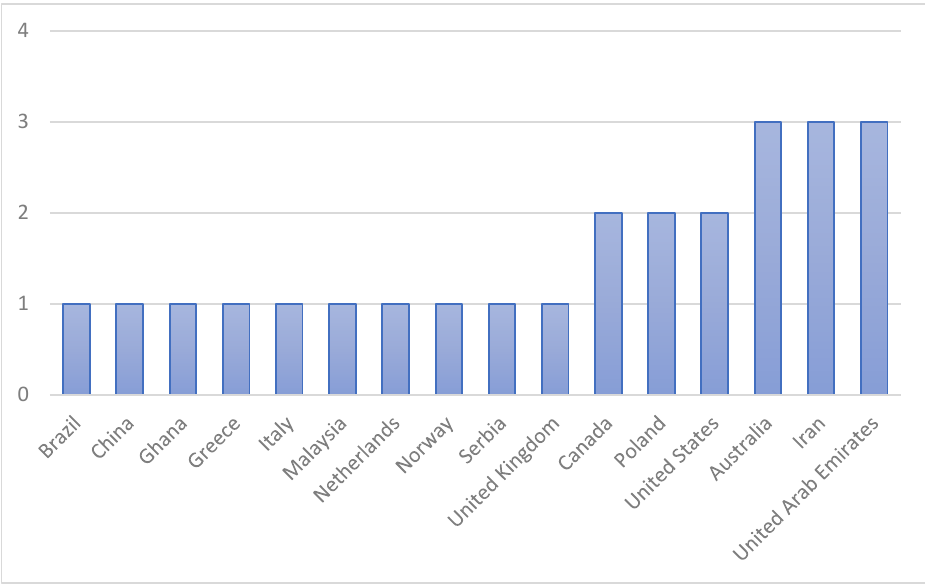
Figure 3. Number of reviewed papers selected by country.